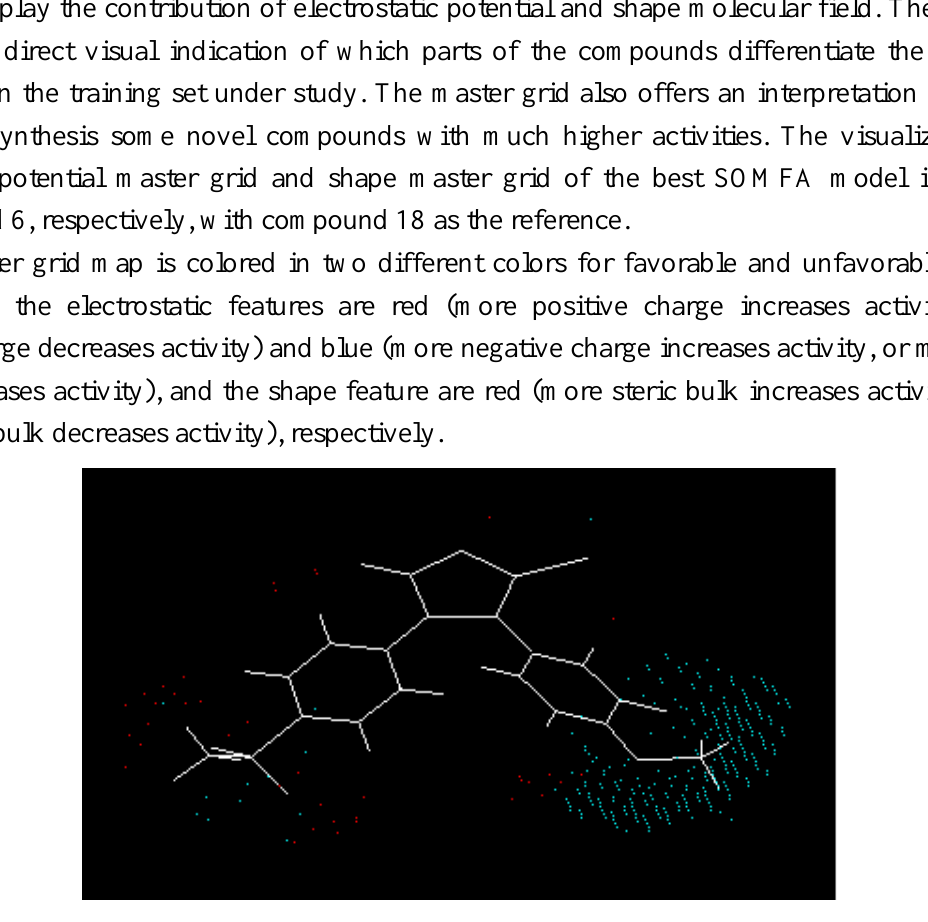
Figure 5. The electrostatic potential master grid with compound 18. Red represents areas where postive potential is favorable, or negative charge is unfavorable. Blue represents areas where negative potential is favorable, or postive charge is